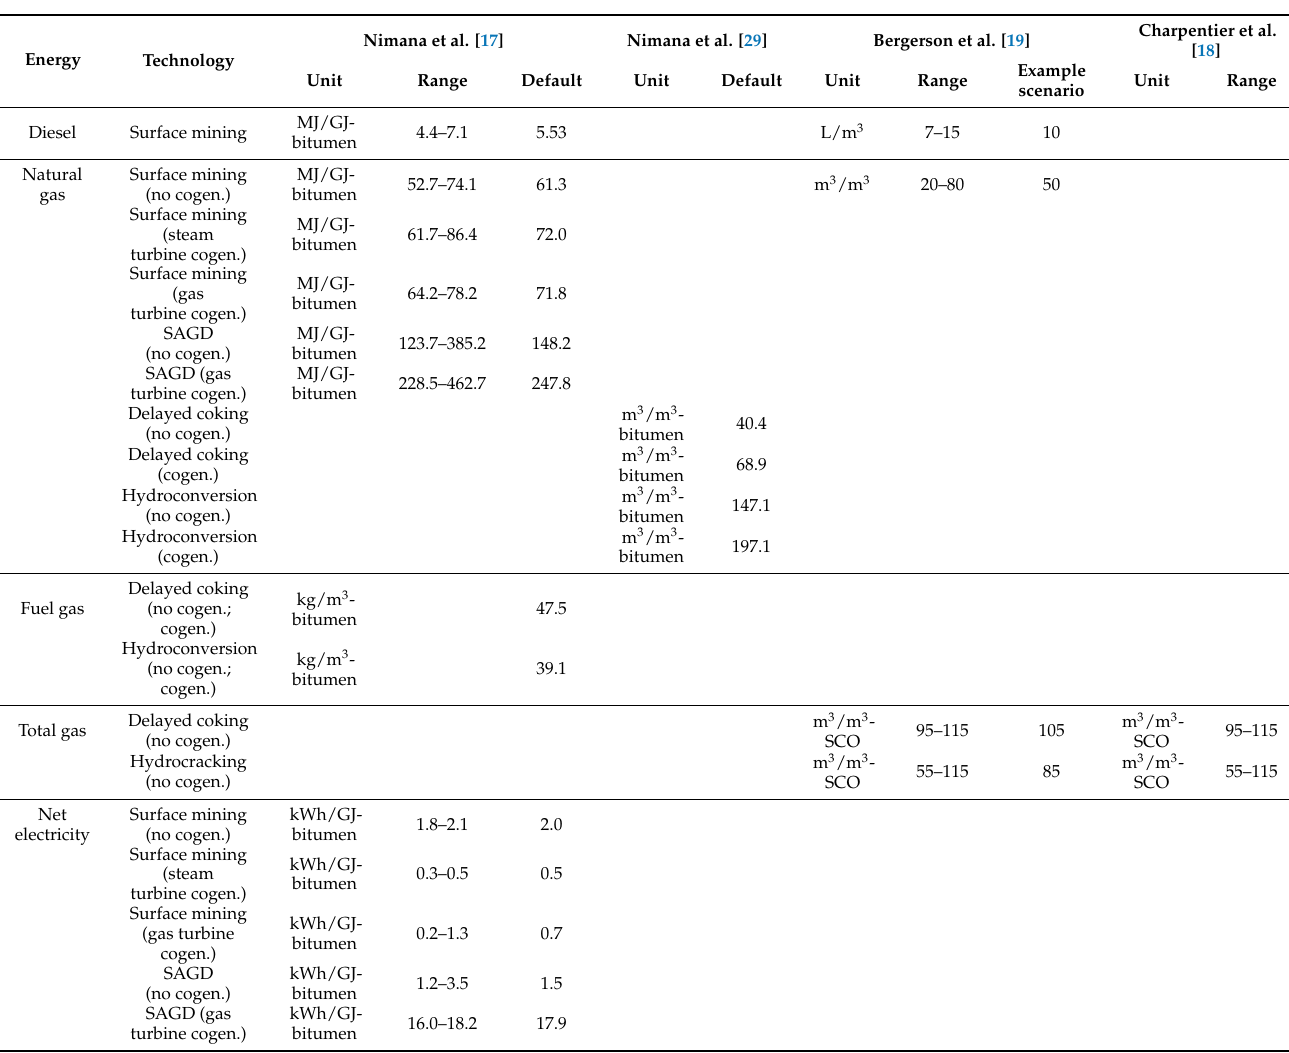
Table 1. Summary of energy input by oil sands